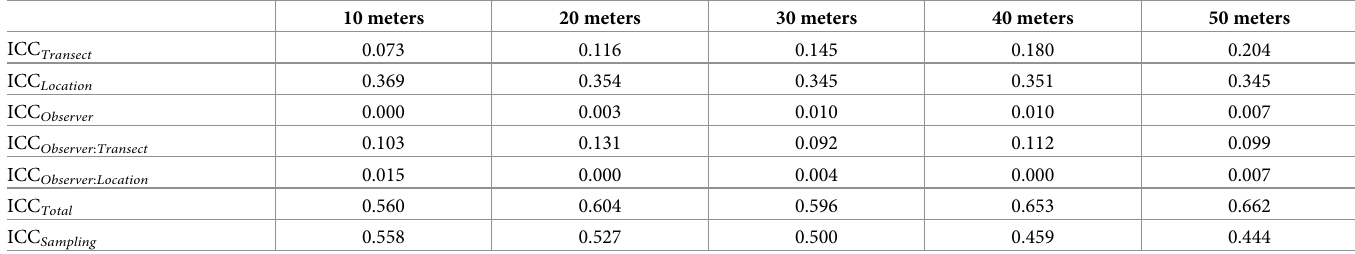
Table 2. Model of the observed species density. Model output (ICC (Intraclass Correlation Coefficient) of the random effects, total ICC explained by the factors of the model and ICC associated with the sampling variability) for a linear mixed model with species density as response, Island as fixed effect, Location and Transect as nested random effects and Observer as crossed random effect. Transect lengths of 10, 20, 30, 40 and 50 meters were assessed.